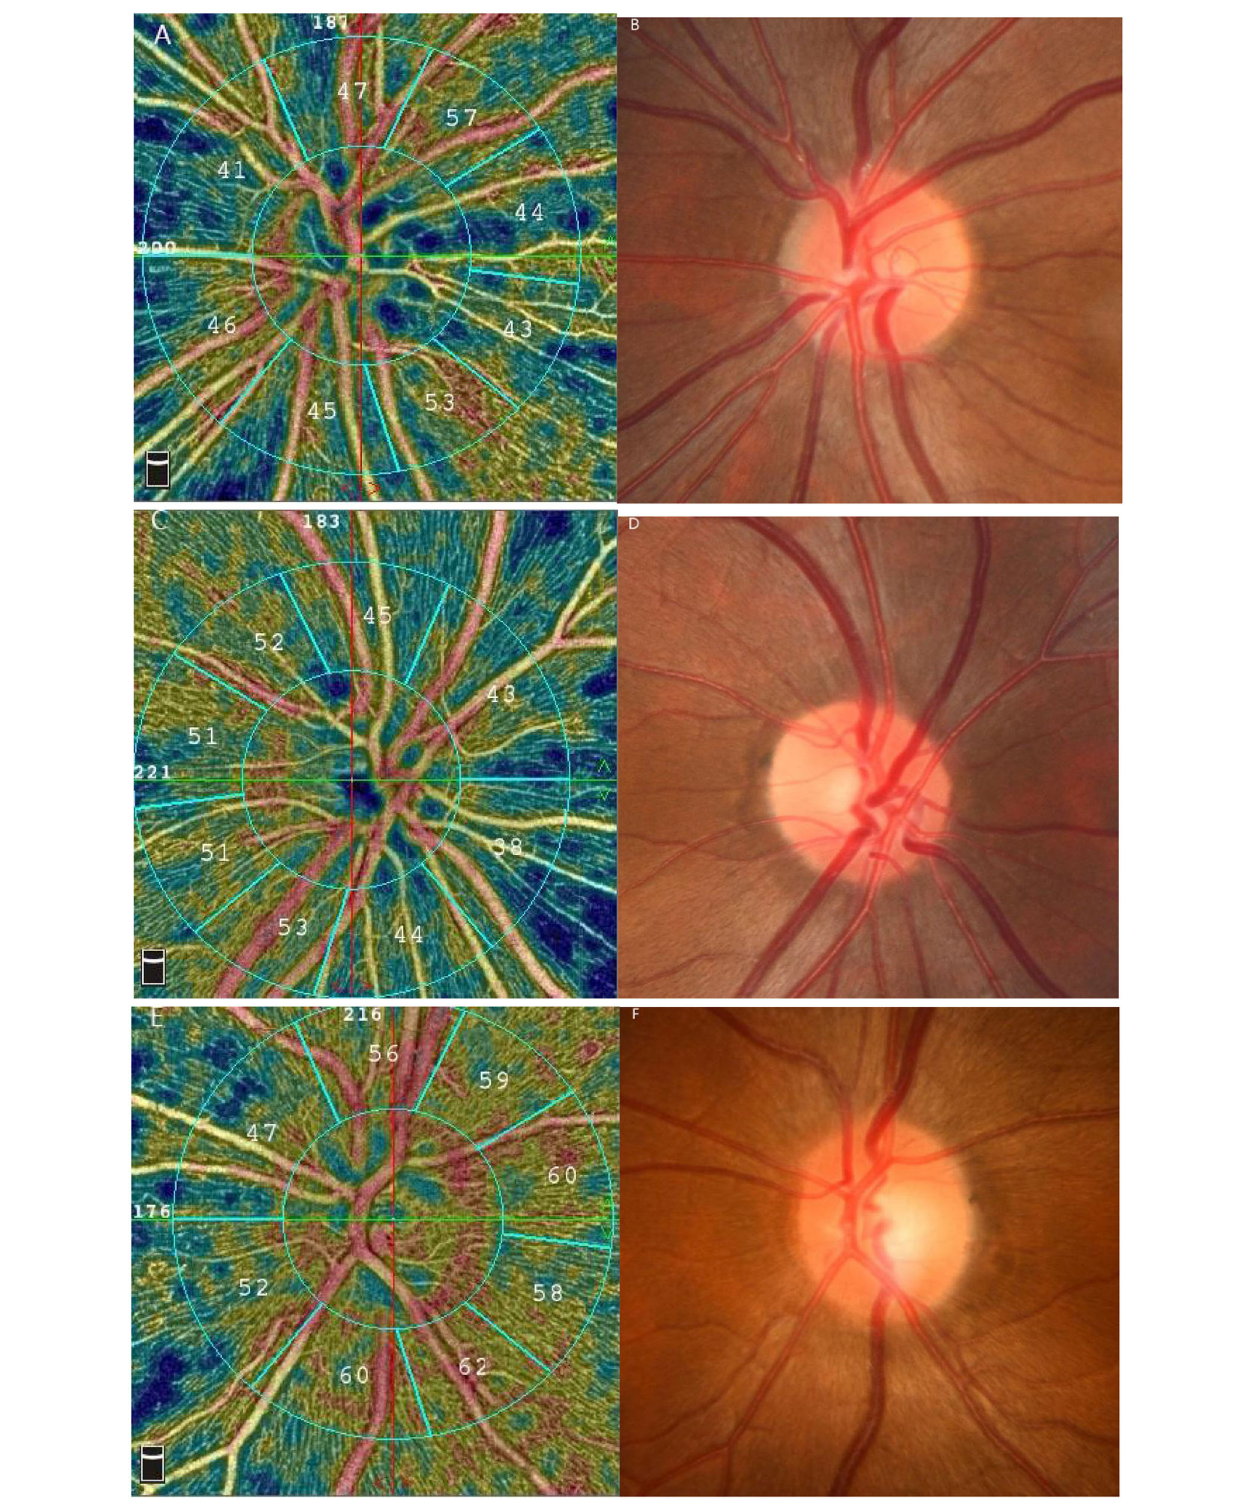
FIGURE 1 | Results of the vessel density by 4.5 × 4.5mm optic nerve scan and the fundus photographs. (A,B) the amblyopic eye (C,D) the fellow eye (E,F) the control eye.